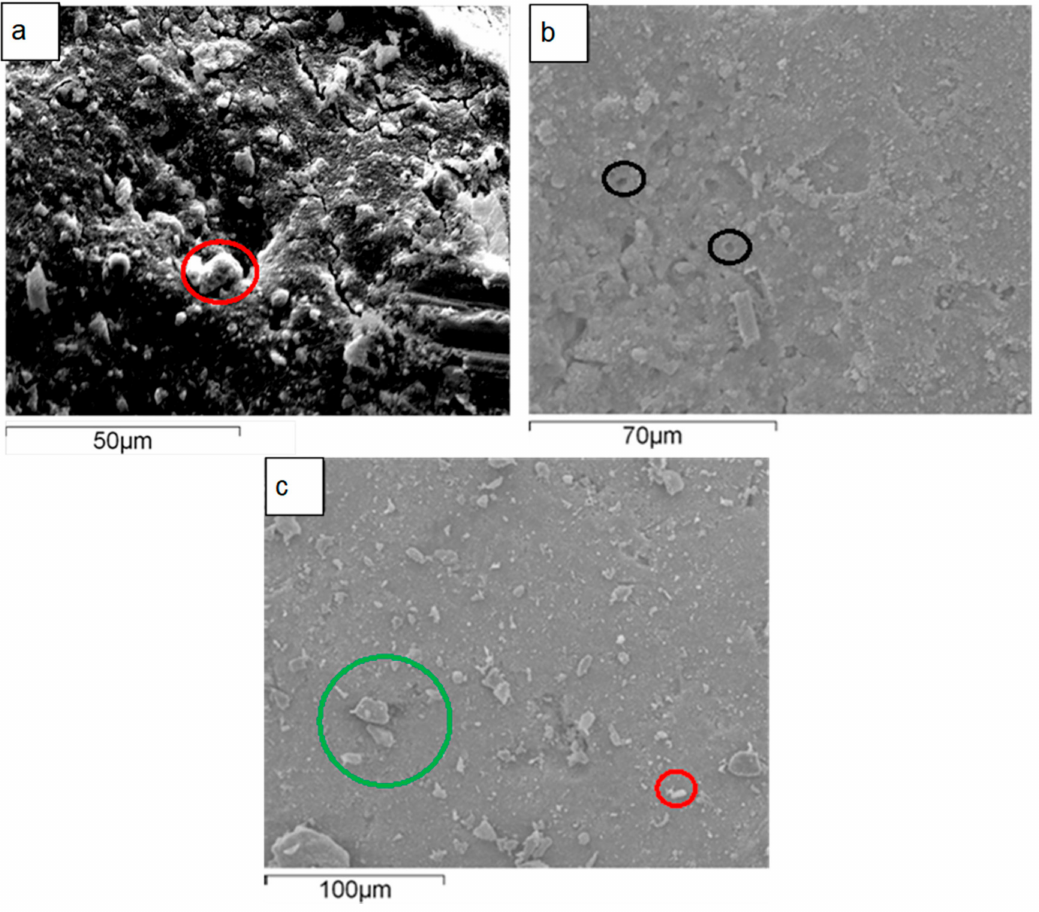
Figure 2. SEM (EDS) micrographs of as-synthesized and reacted catalysts at 500 ◦ C and 700 ◦ C and Steam to Carbon Ratio S/C = 3: ( a ) 10%Ni as-synthesized, ( b ) 10%Ni reacted at 500 ◦ C and ( c ) 10%Ni reacted at 700 ◦ C.